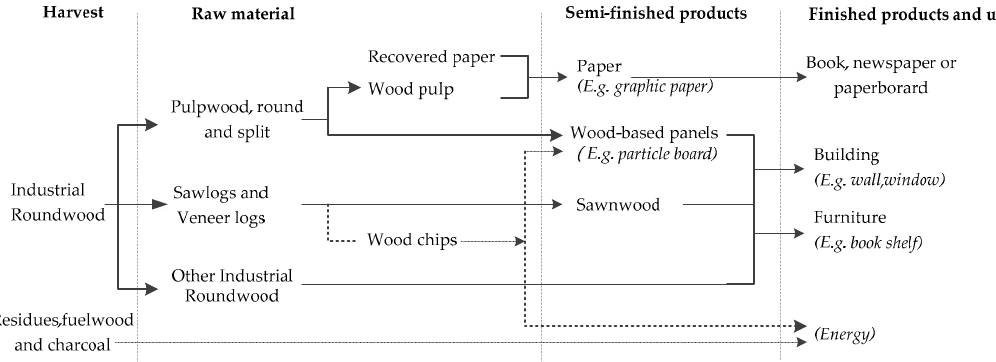
Figure 1. Different processing stages of wood products along the harvested wood products (HWP) process and value chain.